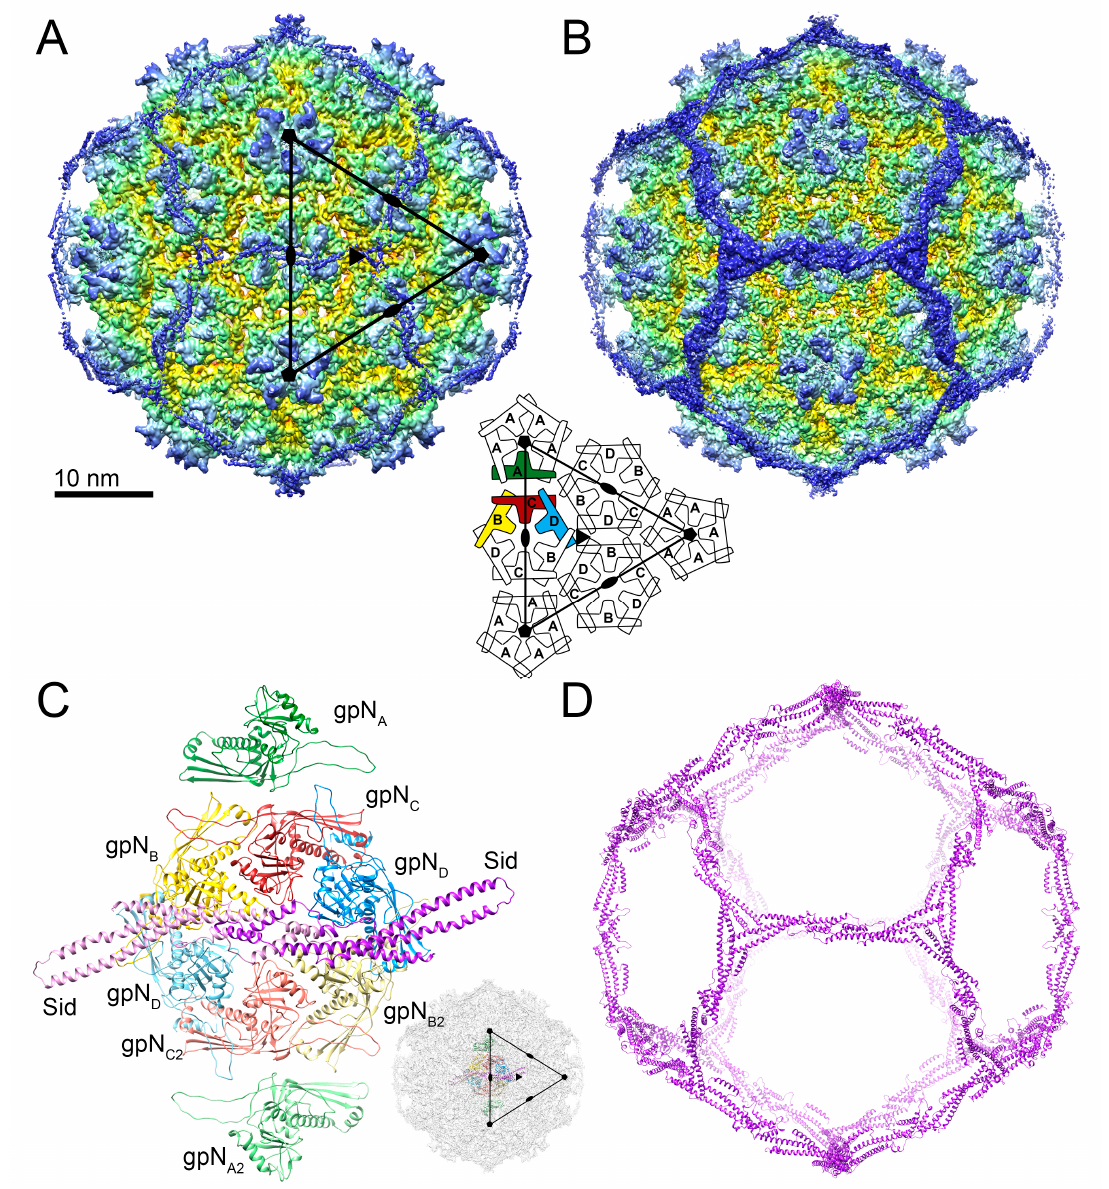
Figure 2. Reconstruction of the P4 procapsid. ( A ) Isosurface representation of the icosahedrally symmetric reconstruction, colored radially from the inside (red) to the outside (blue). The triangle represents one icosahedral face (three asymmetric units); the icosahedral symmetry axes are indicated. The schematic diagram shows the arrangement of gpN subunits in the T = 4 lattice. ( B ) Isosurface representation of the asymmetric reconstruction, viewed as in ( A ). ( C ) The atomic model, showing two complete icosahedral asymmetric units, including 8 copies of gpN (A–D and A2–D2) and two copies of Sid. One of the asymmetric units is shown with lighter color. The inset shows the orientation of the model within the capsid. ( D ) Ribbon diagram showing the entire dodecahedral cage formed by